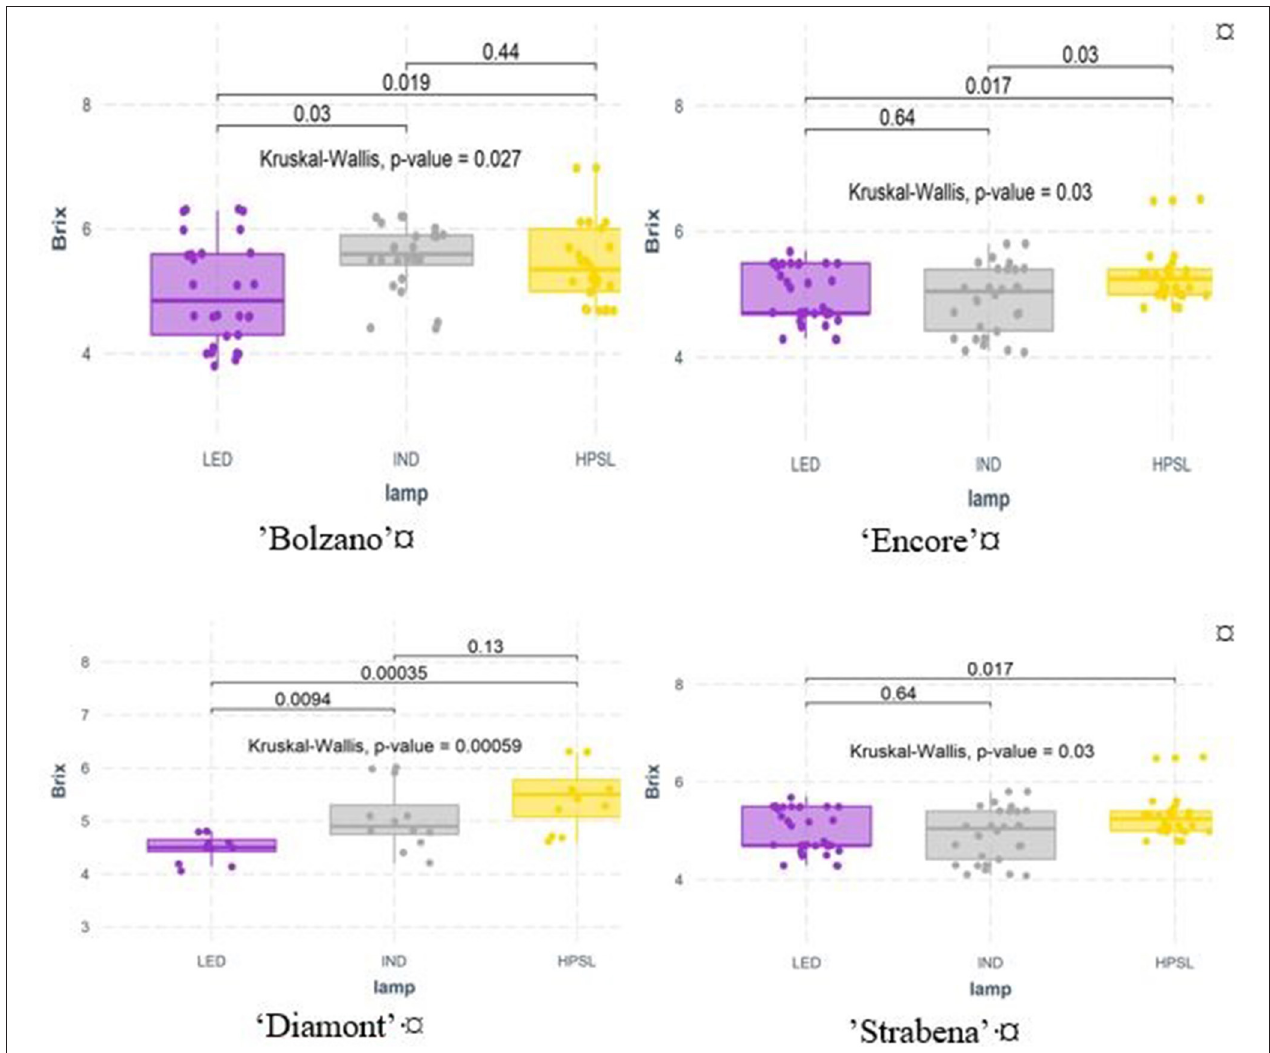
FIGURE 6 | Soluble solids (Brix) in tomato fruits grown under different supplemental light